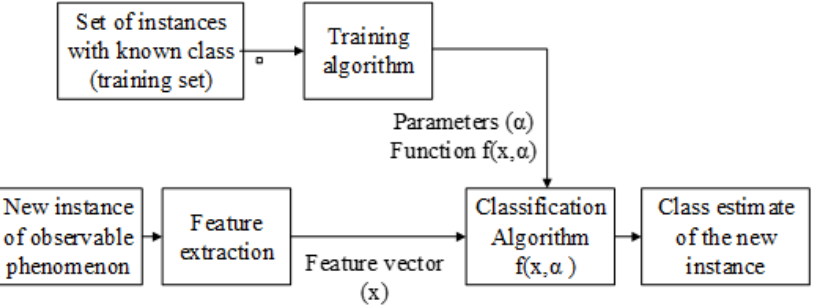
Figure 2. Depiction of the intended goal of the authors ’ work by providing the best possible failure type estimate with data available in almost real time. type estimate with data available in almost real